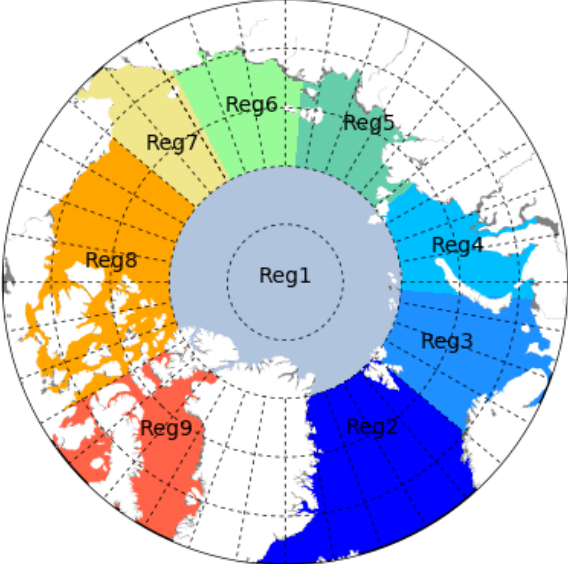
Figure 10. Subregions for spatial differentiation of initial and boundary values in the control vector. 1 (light plum) is central Arc- tic, 2 (dark blue) is North Atlantic, 3 (blue) is Barents Sea, 4 (light blue) is Kara Sea, 5 (green) is Laptev Sea, 6 (light green) is East Siberian Sea, 7 (yellow) is Bering Strait/Chukchi Sea, 8 (orange) is Beaufort Sea, and 9 (red) is Baffin